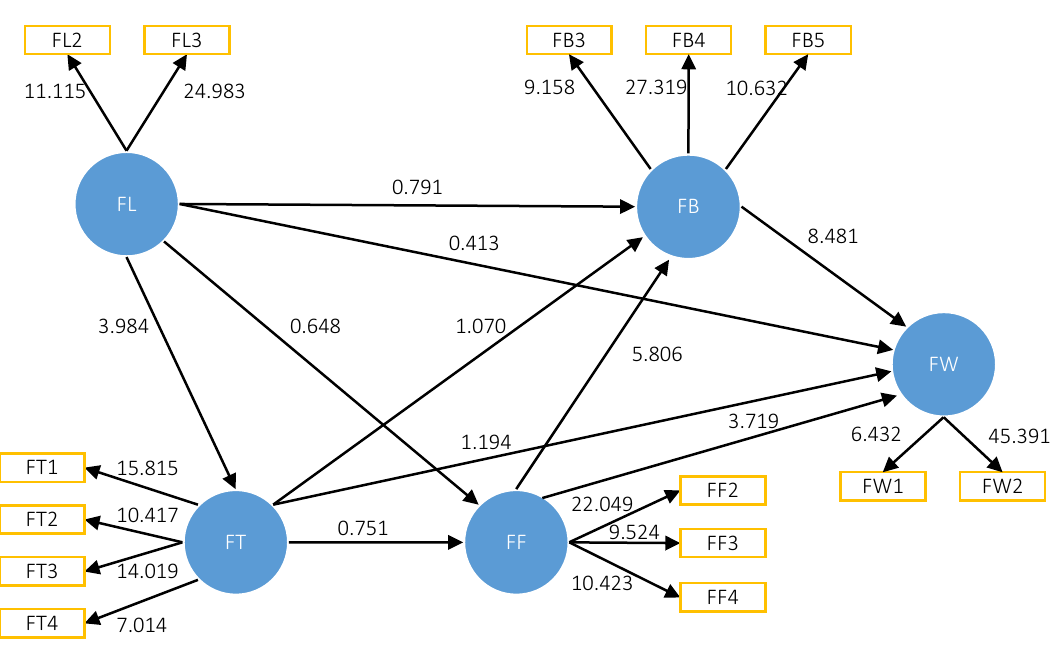
Figure 3. PLS-SEM with t -statistics, bootstrapping with 5,000 samples Table 7. Path coefficients, t -statistics and p -values of the structural model